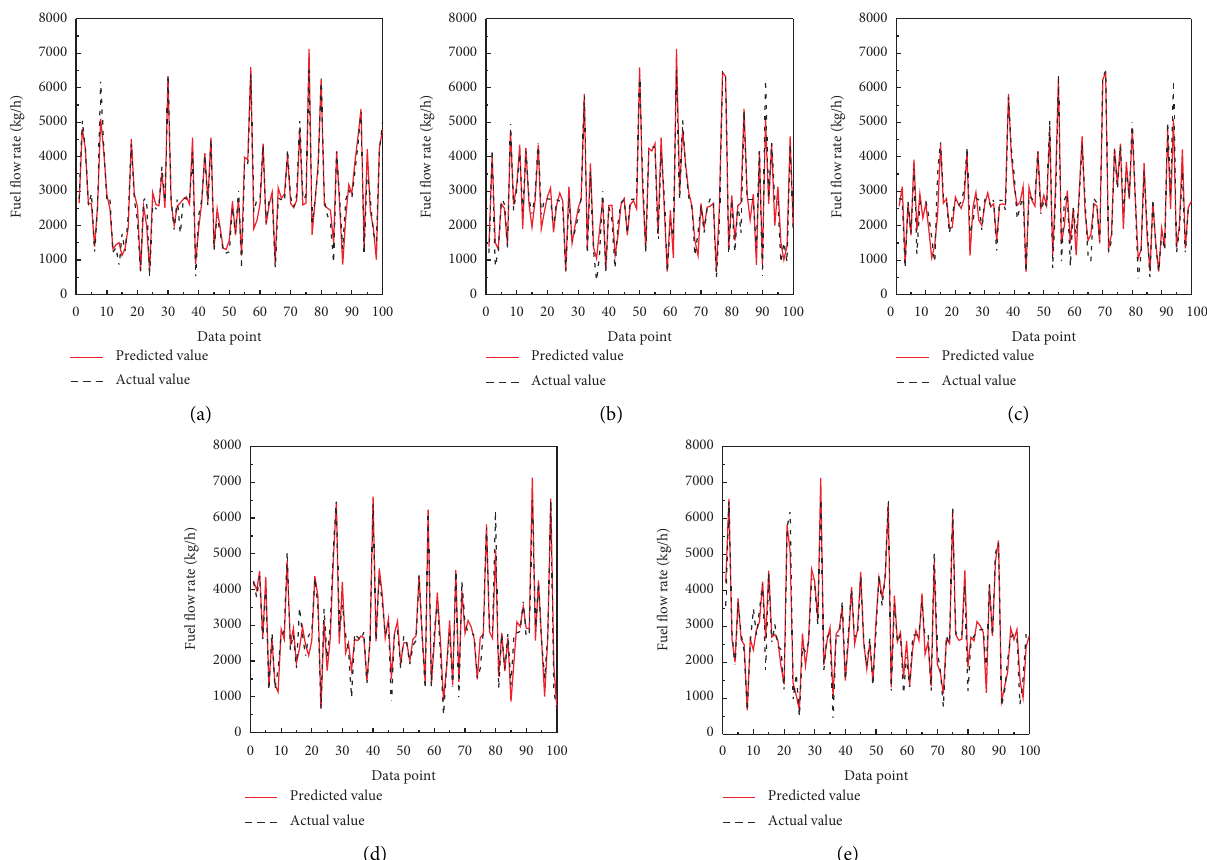
Figure 5: Comparison of the predicted and actual FFR values for the validation dataset of 5 groups including (a) G1, (b) G2, (c) G3, (d) G4, and (e)